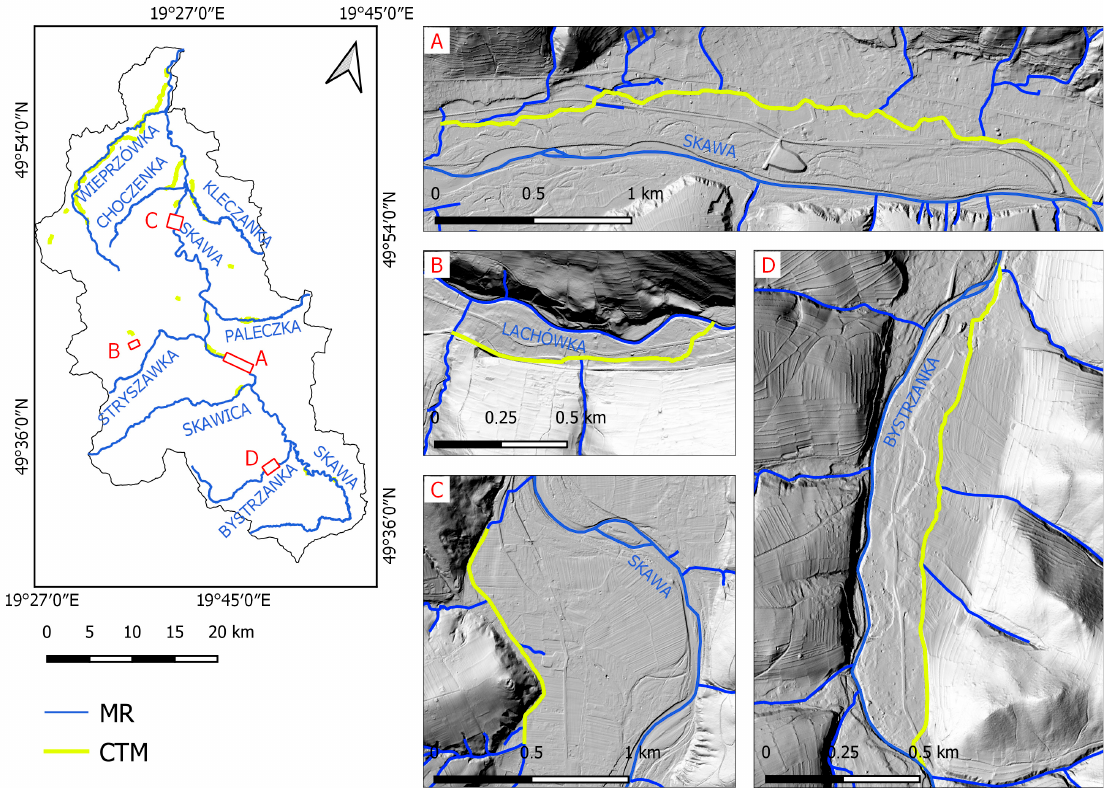
Figure 6. Selected millraces in the contemporary river catchment network of the River Skawa: MR—main rivers, CTM—contemporary traces of millrace in: ( A )—Mak ó w, ( B )—Lachowice, ( C )—Jaroszowice, ( D )—Bystra Podhala´nska. Relief shading in underlay